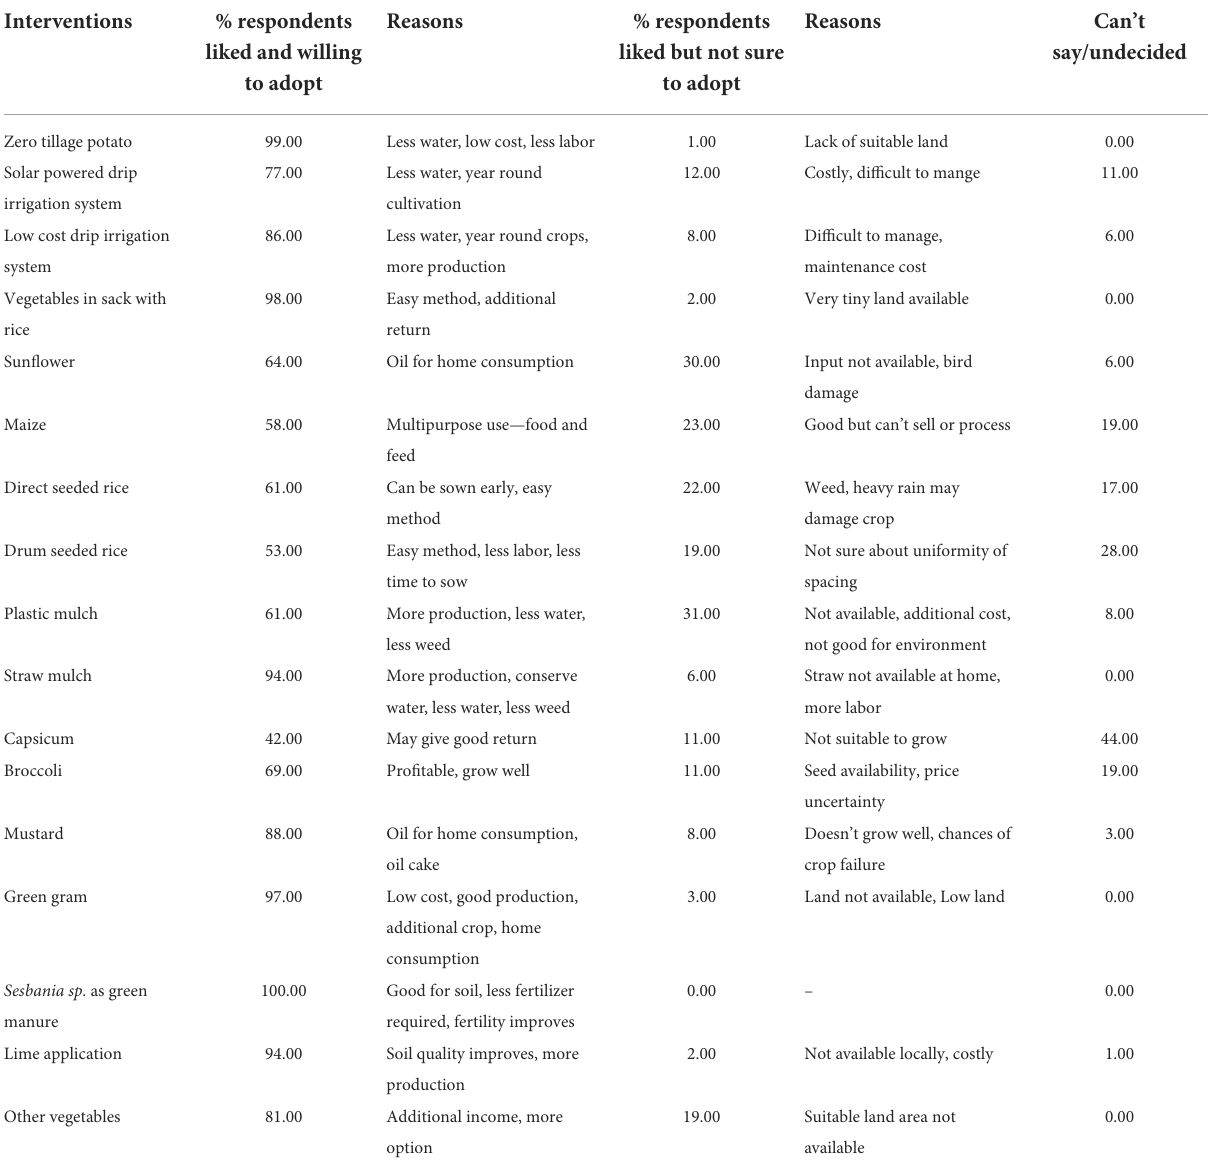
TABLE 4 Farmers perceptions on interventions and improved practices of agriculture. Interventions % respondents Reasons liked and willing liked but not sure to adopt